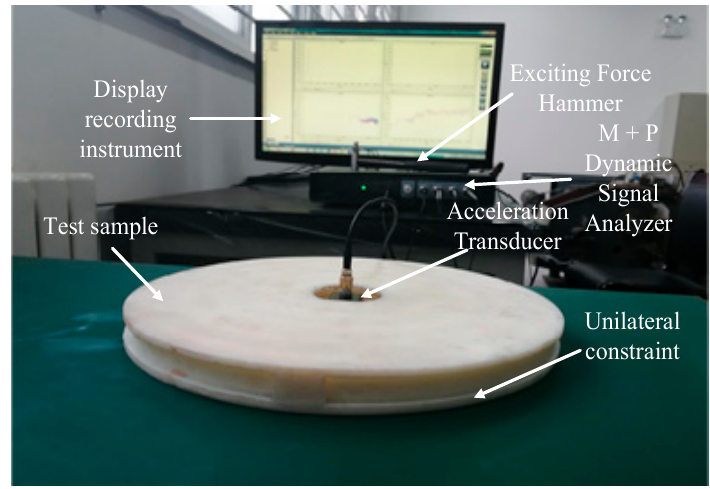
Figure 18. Experimental test system.